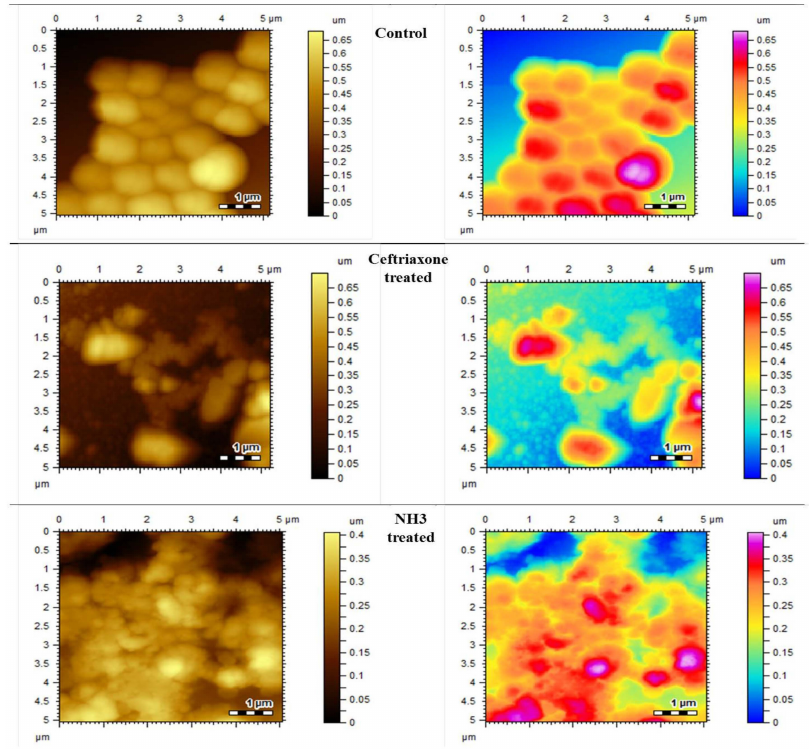
Figure 3. Atomic force microscopic images of control, standard and most effective treatment groups.